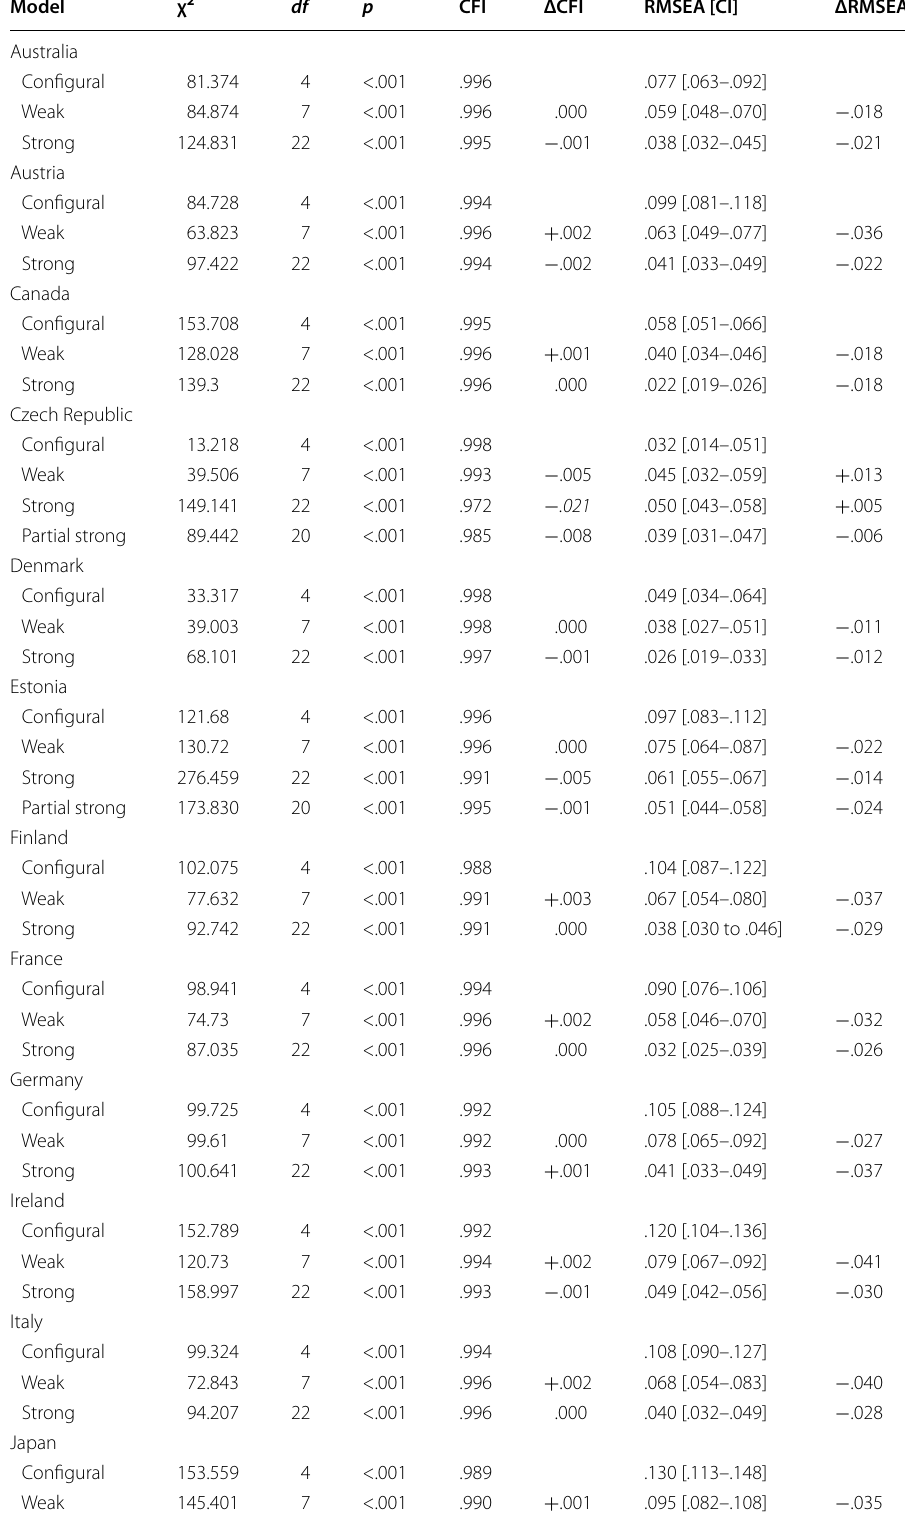
Table 3 Detailed model fit with gender as grouping variable